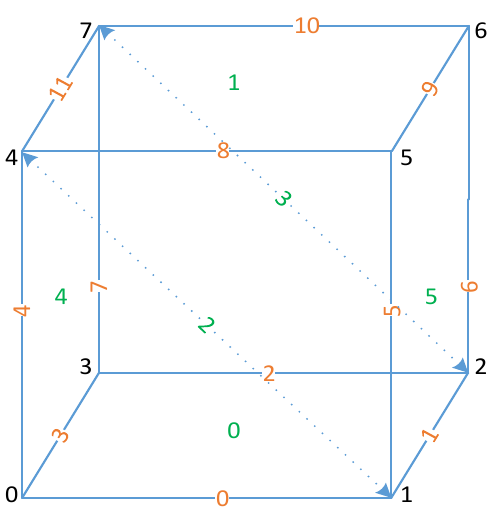
Figure 4. Data structures of tangent